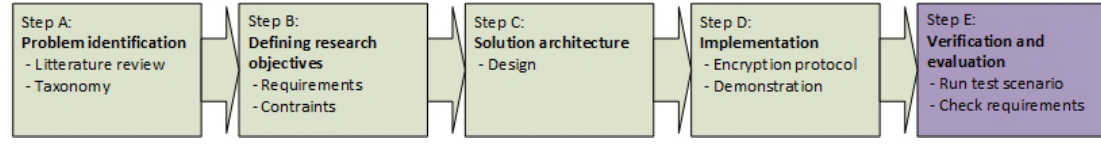
Figure 1. Research